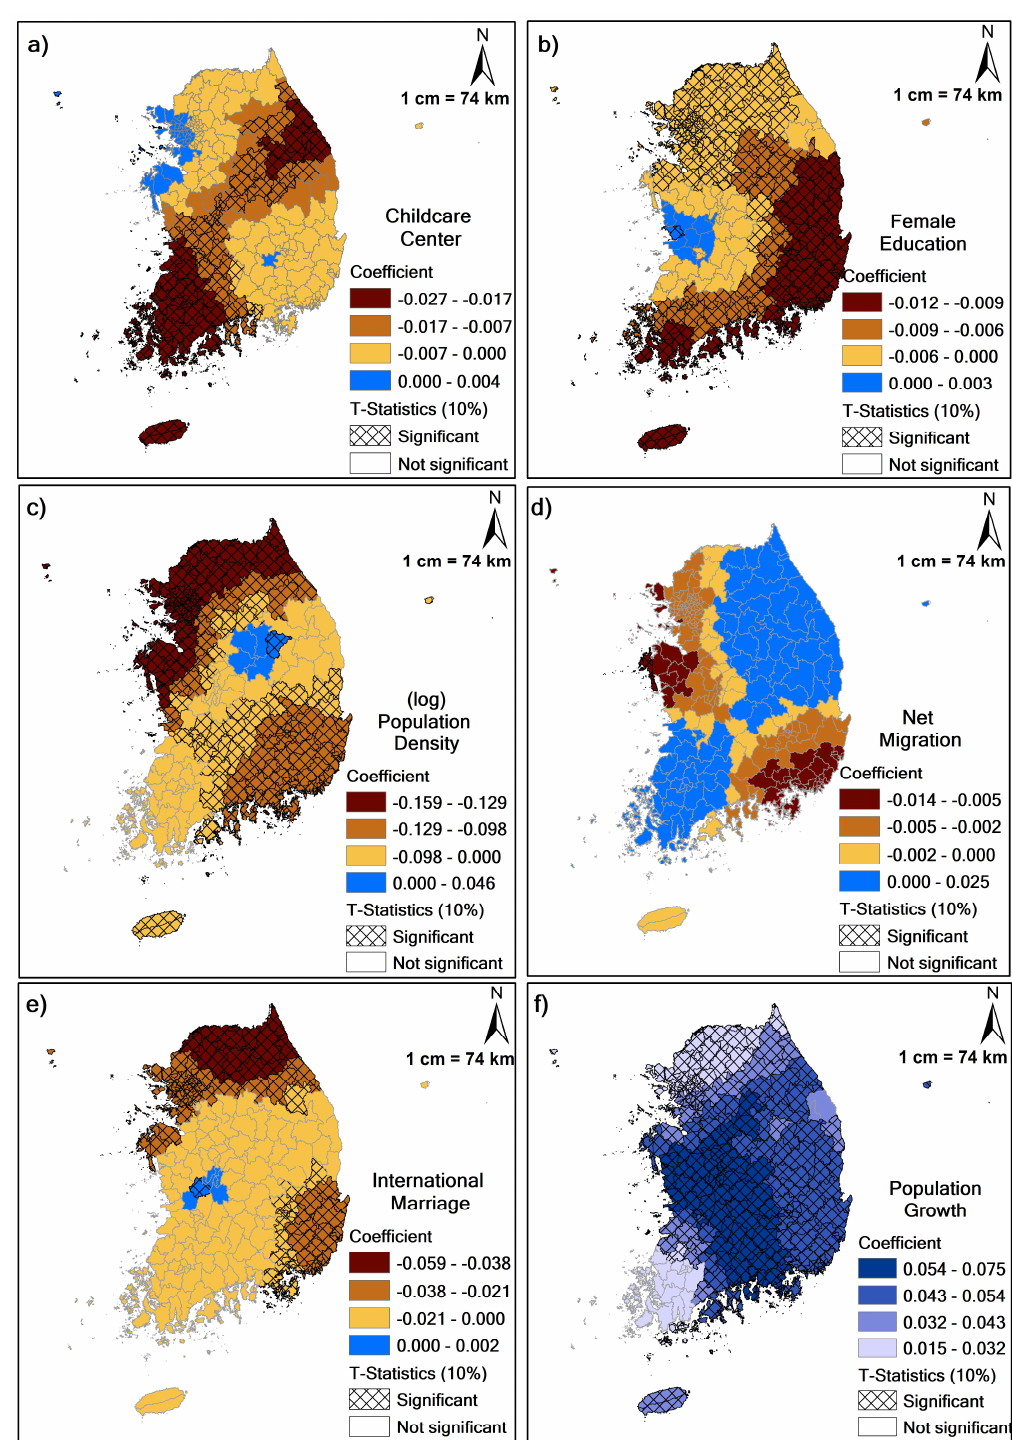
Figure 4. Spatial distribution of GWR local coefficients: ( a ) Childcare Centers; ( b ) Female Education; ( c ) Population Density; ( d ) Net Migration; ( e ) International Marriage; ( f ) Population Growth.